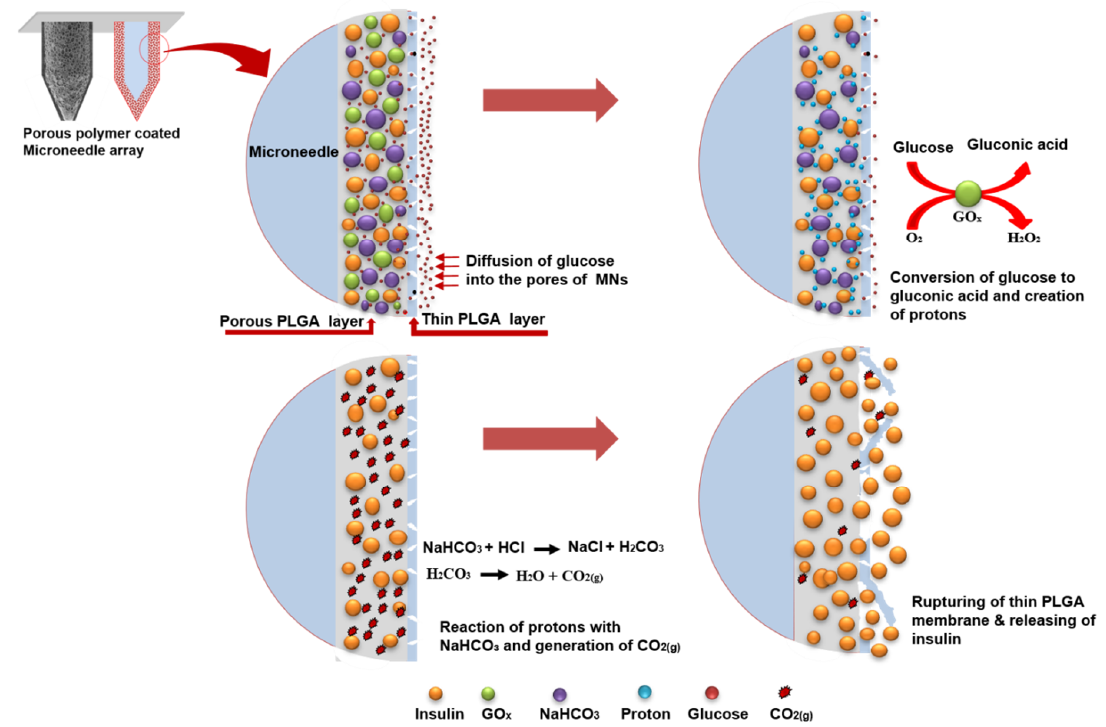
Figure 1. Schematic demonstration of the glucose-responsive insulin delivery system using porous coated microneedles (MNs).